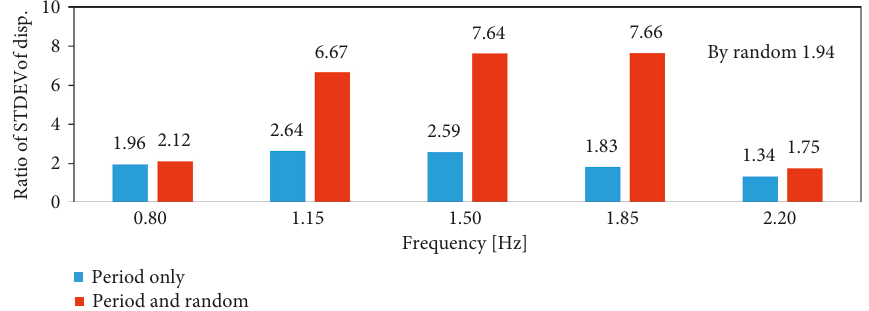
Figure 14: Verification result of the amplification effect caused by stochastic resonance.